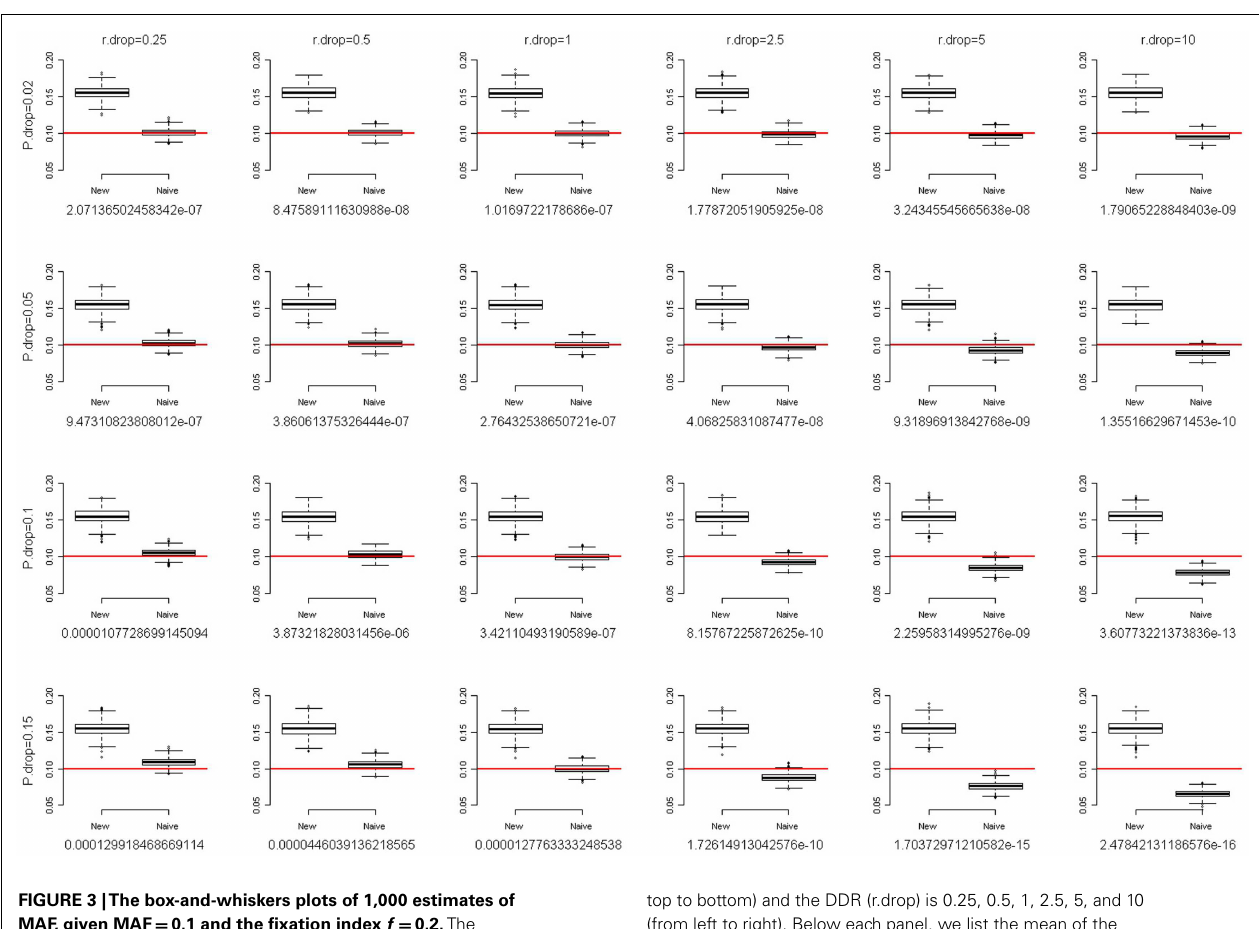
FIGURE 3 |The box-and-whiskers plots of 1,000 estimates of MAF, given MAF = 0.1 and the fixation index f = 0.2. The different panels in the figure are arranged so that the overall genotype missing rate (P.drop) is 0.02, 0.05, 0.1, and 0.15 (from